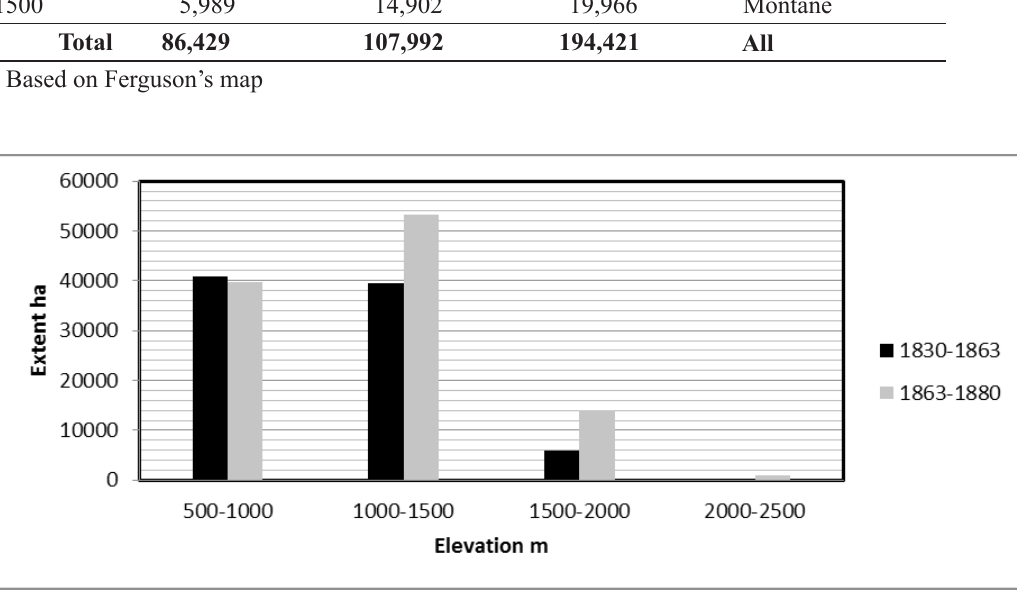
Figure 7: Extents of coffee estates by elevation zone as stood in the years 1863 and 1880.